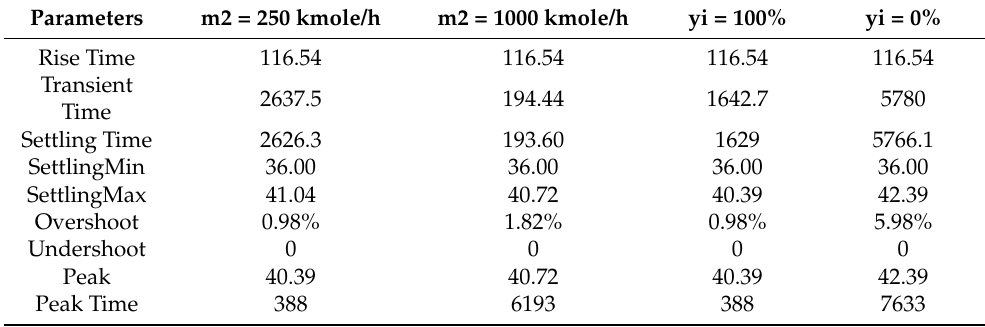
Table 3. Step-response characteristics for system in Figure 10.